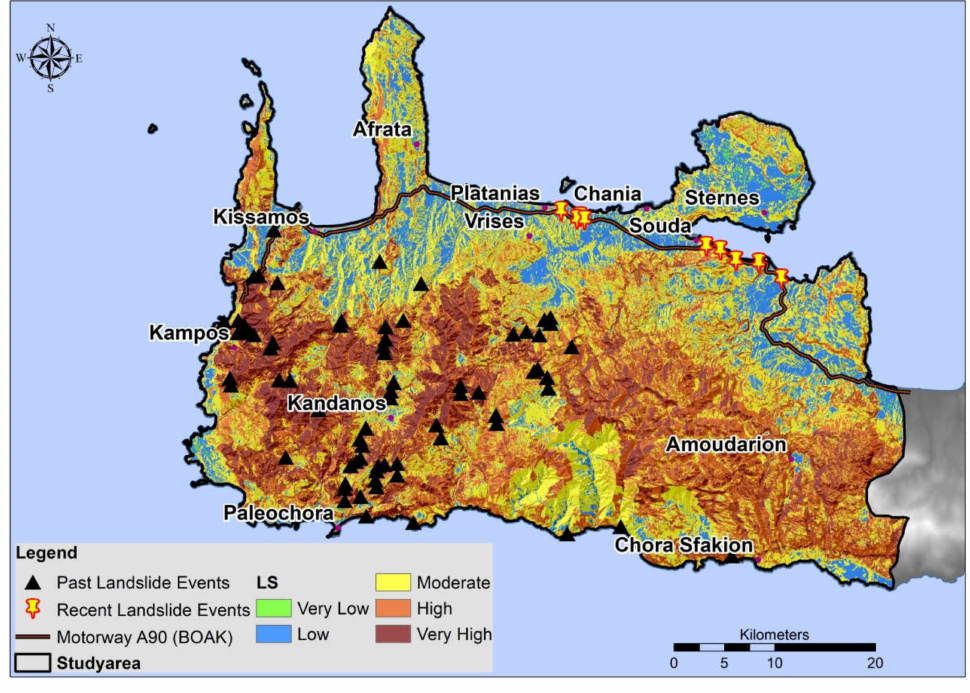
Figure 7. The Landslide Susceptibility (LS) map, after reclassifying the calculated values into five classes of potential susceptibility.